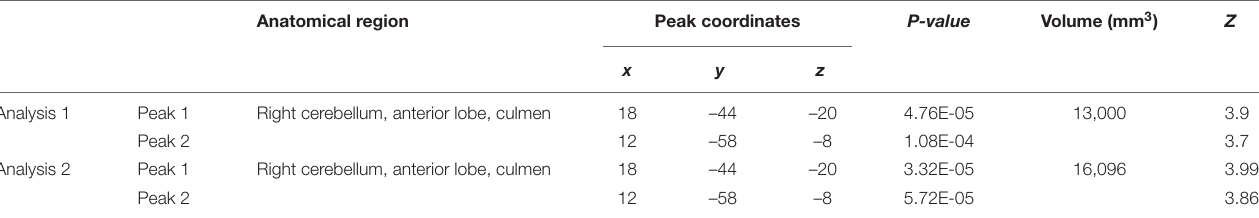
TABLE 3 | Cluster coordinates.